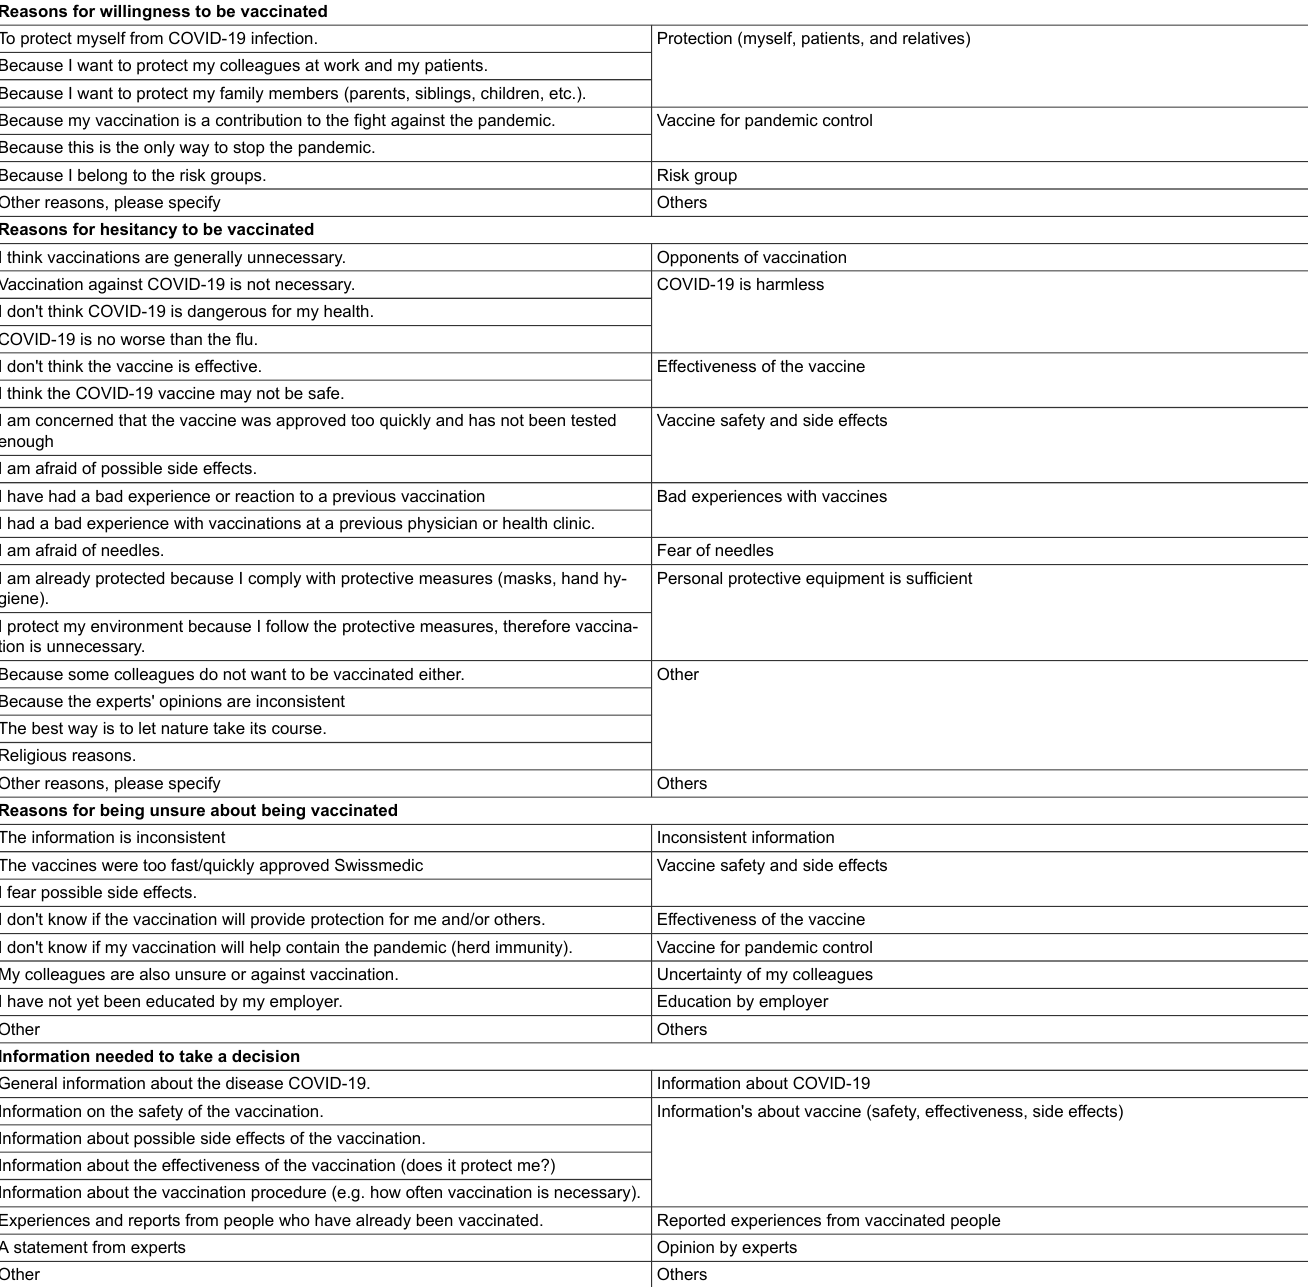
Table S1: Grouping of the reasons for willingness or hesitancy to be vaccinated against COVID-19 or uncertainty about vaccination. Reasons for willingness to be vaccinated To protect myself from COVID-19